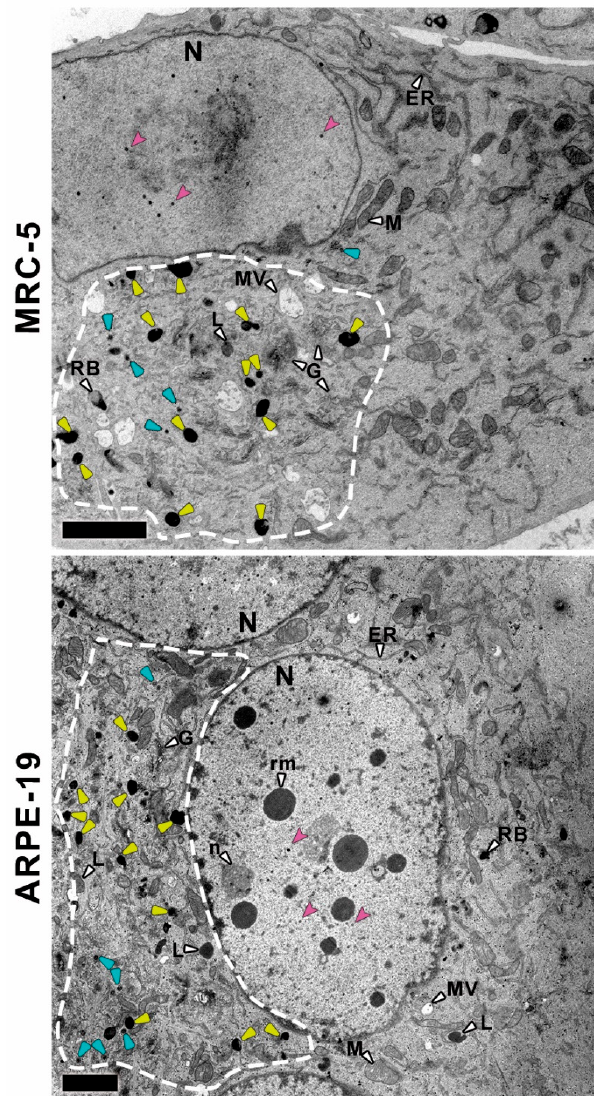
Figure 1. Panoramic view of CMV-infected MRC-5 and ARPE-19 in all legend cells.A cytoplasmic inclusion (CI; dashed lines) is located in the left half of the MRC-5 image, under the nuclear area. Proliferation of fragmented cisterna along with electron DB (yellow arrowheads) and viral capsids (blue arrowheads) can be observed, which are not visible in the half right. In the left side of the ARPE-19 cell image, a massive change in the cytoplasm corresponding to the CI (dashed lines) can be observed. CI consists of viral capsids (blue arrowheads), hundreds of membrane cistern (putative Golgi elements), apparently fragmented in shorter elements, and putative DB (yellow arrowheads), not appreciable in the right side. Nuclei from both MRC-5 and ARPE-19 cells contain CMV nucleocapsids (pink arrowheads). However, the ARPE-19-infected nucleus exhibits a cluster of electron dense round masses, not found in the nuclei from MRC-5-infected cells.Cellular organelles and structures are labeled with letters and pointed out with white arrowheads: N––nucleus,